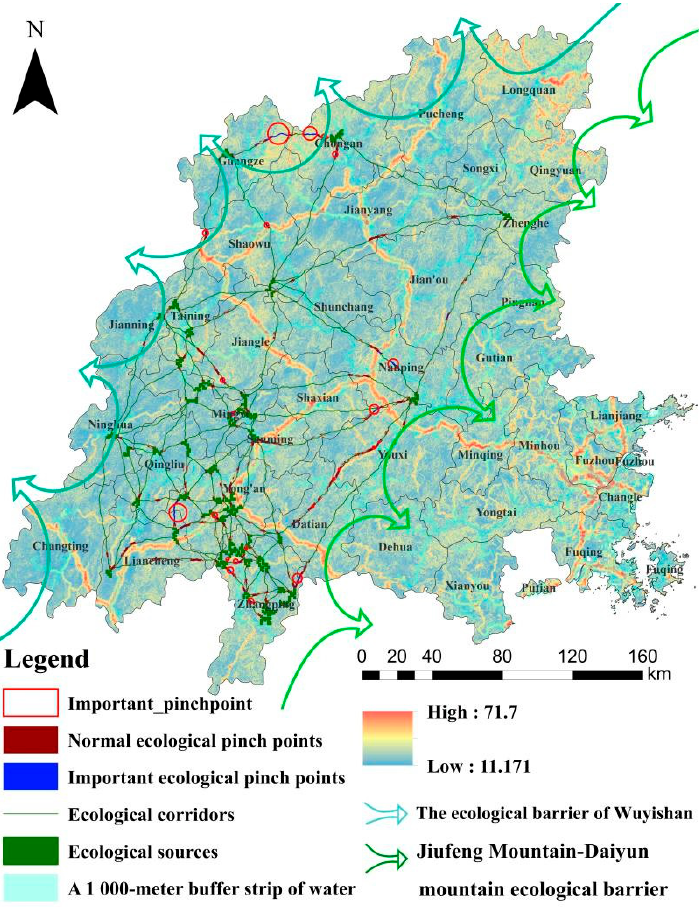
Figure 6. Construction of an ecological security pattern in the Minjiang River Basin.